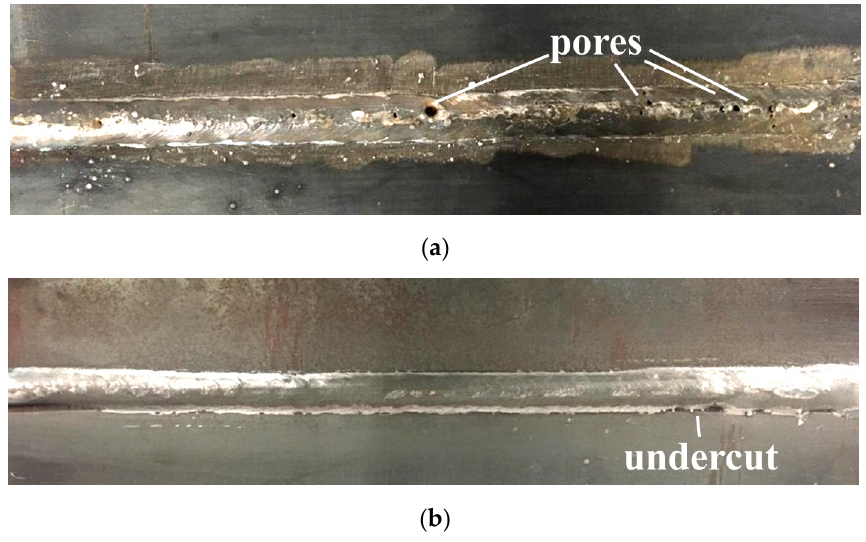
Figure 5. View of: ( a ) specimen SW and ( b ) specimen SA.